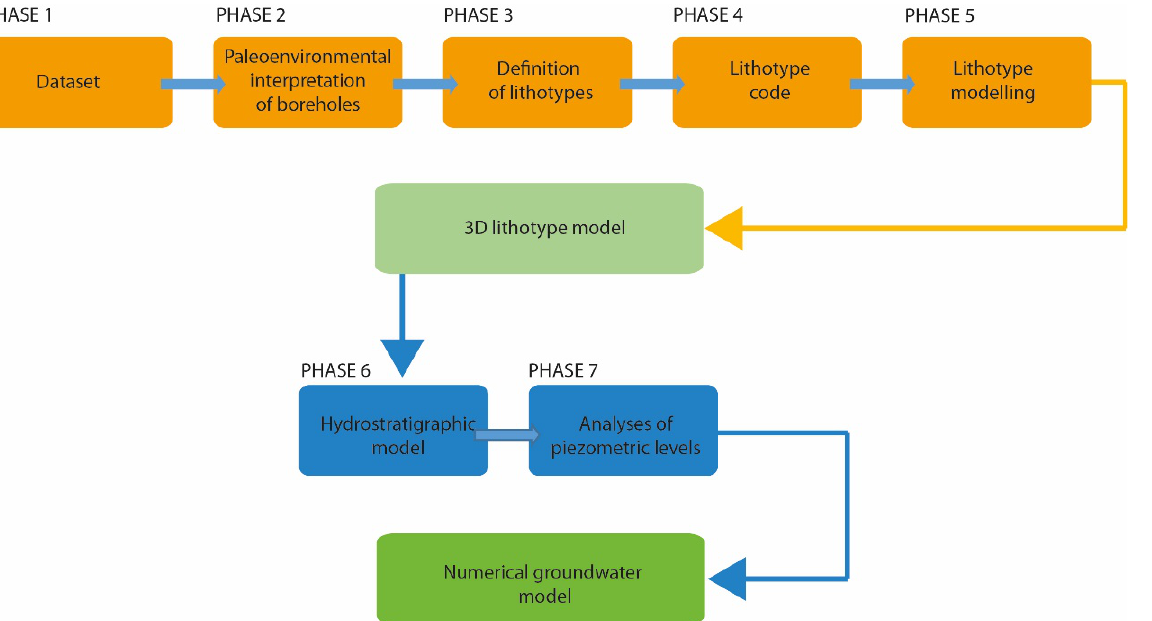
Table 2. Coordinates (UTM WGS84, 33N), elevation, and depth of drilled boreholes. The distance between the wells and the riverbank was calculated orthogonally to the axis of the river. The distance between the well and the mouth of the river, along both the median of the alluvial valley and the river channel, was also calculated. Borehole River Mouth River Mouth X (UTM Y (UTM Elevation Distance from Distance along the Depth Distance along Borehole WGS84) WGS84) (m a.s.l.) the Riverbank Alluvial Valley (km) (km) the River (km) S1